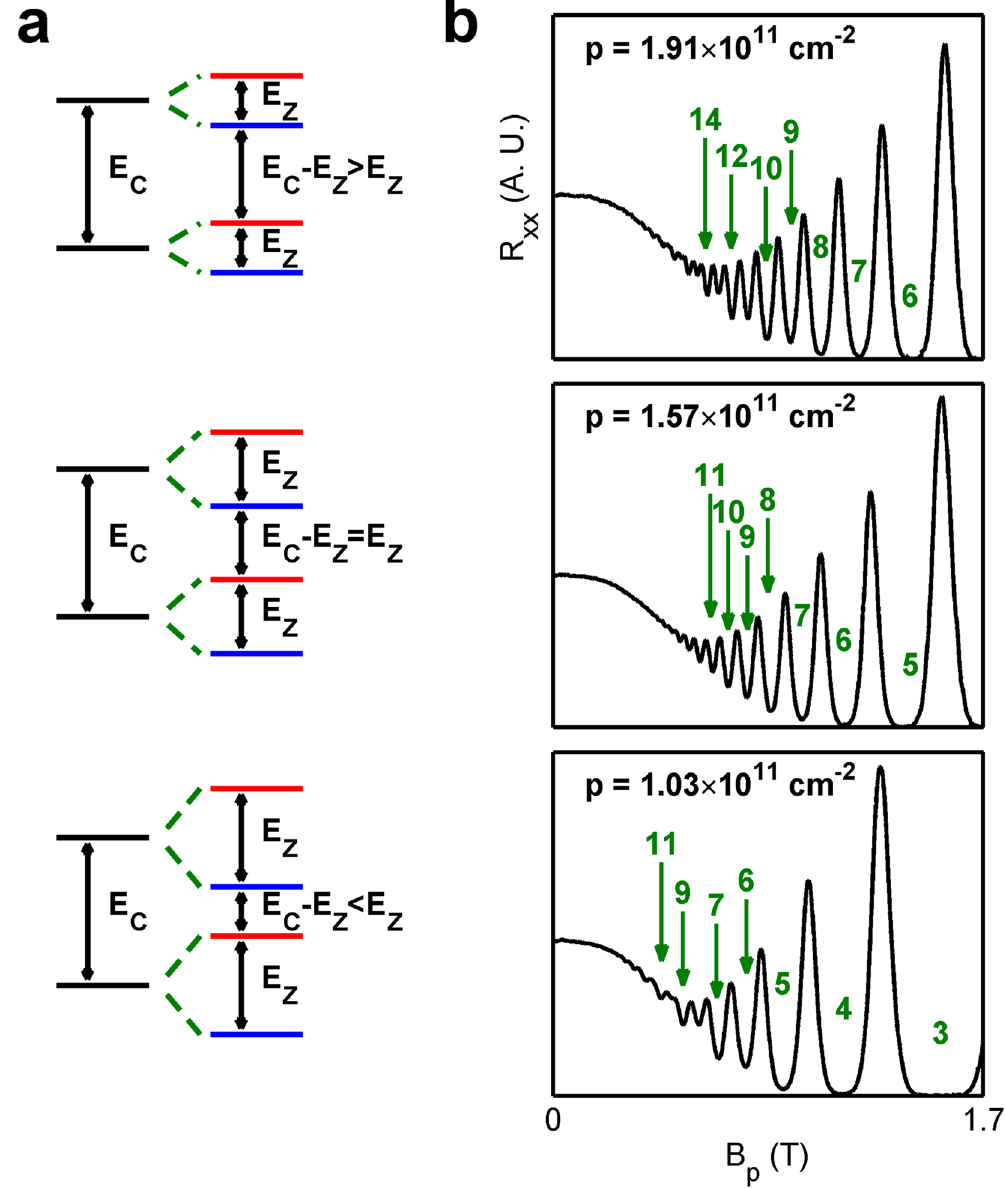
Figure 1. ( a ) The Landau level ladders of a 2D system in a perpendicular magnetic field at E z / E c < 0.5, E z / E c ~ 0.5, E z / E c > 0.5. Here, E z is the Zeeman splitting and E c is the cyclotron gap. The red (blue) lines are spin up (down) Landau levels. ( b ) R xx of 2D holes in Ge at T = 0.3 K. From top to bottom, the densities are: 1.91 × 10 11 cm − 2 , which shows strong even states, 1.57 × 10 11 cm − 2 , which shows equally strong even and odd states, and 1.03 × 10 11 cm − 2 , which shows strong odd